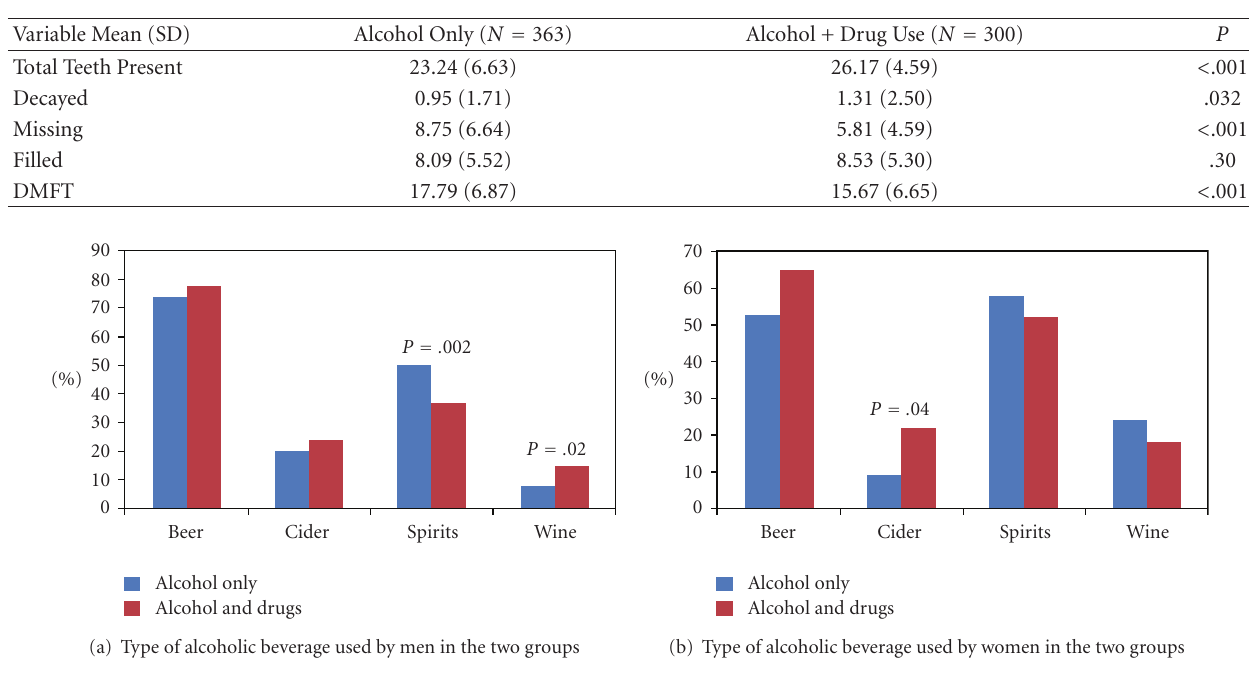
Table 2: Remaining teeth and caries status by group.